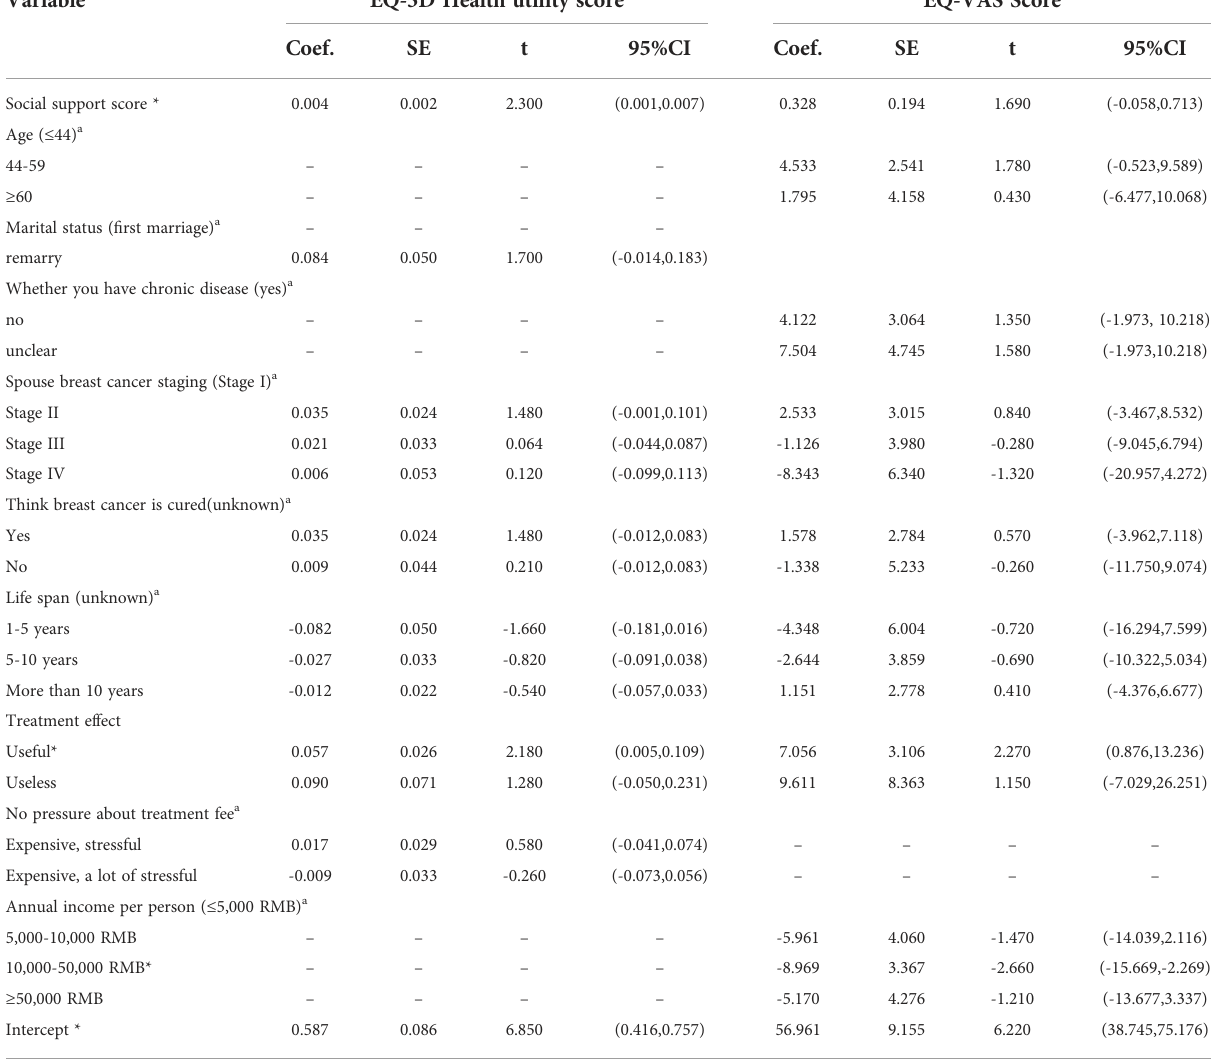
TABLE 7 Analysis of factors affecting the quality of life of spouses in patients with breast cancer. Variable